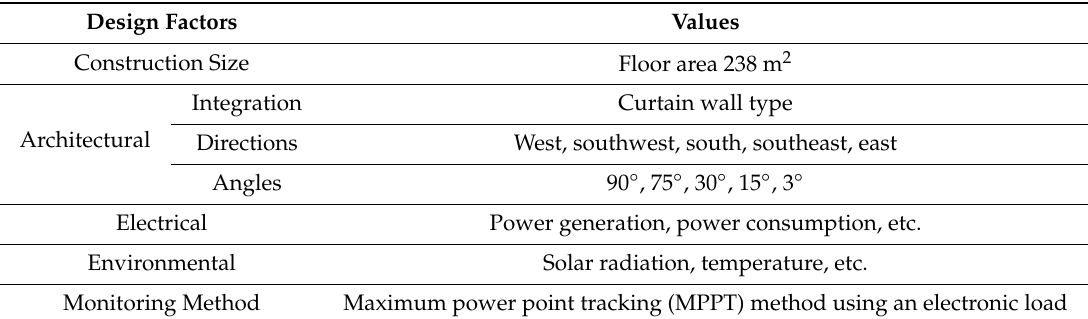
Table 3. The design specifications for a building-integrated PV (BIPV) mock-up test building.